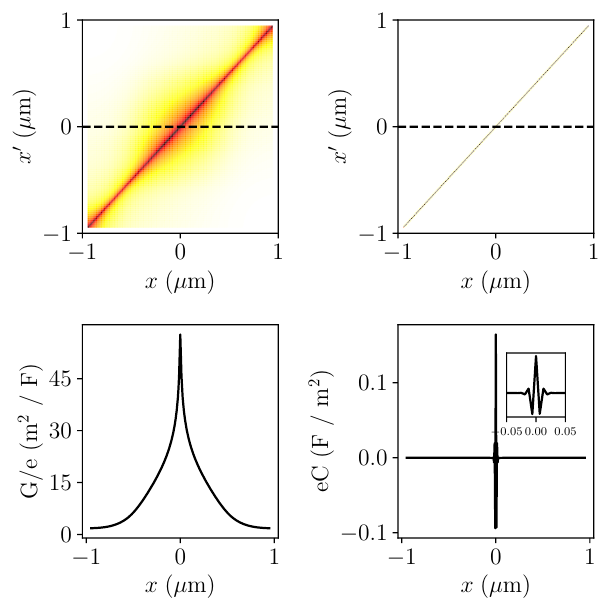
Figure 4: Green’s function G (left) and Capacitance matrix C (right) for the geometry shown in Fig. 1(b). Top panels: 2D colormaps of G (left) and C (right). Lower xx (cid:48) xx (cid:48) panels: 1D cuts G (left) and C (right). Inset: zoom of the lower right panel. x ,0 x ,0 The C matrix is very local while the G matrix is